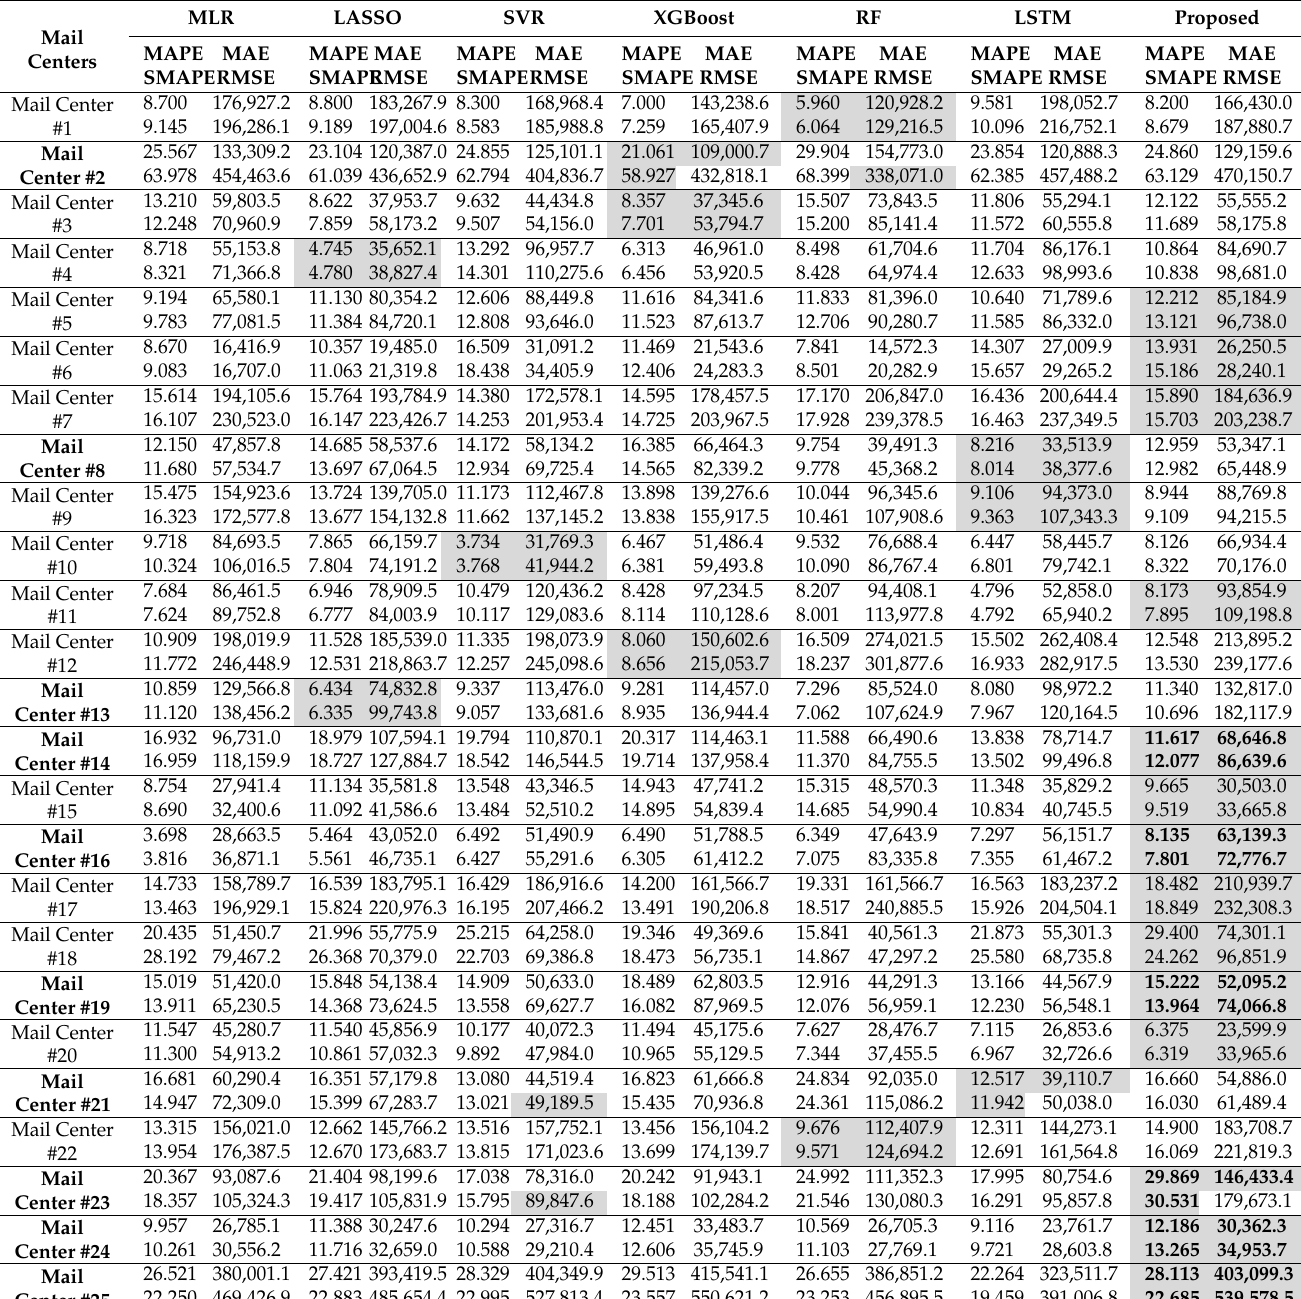
Table 3. Comparison of MAPE, SMAPE, RMSE and MAE